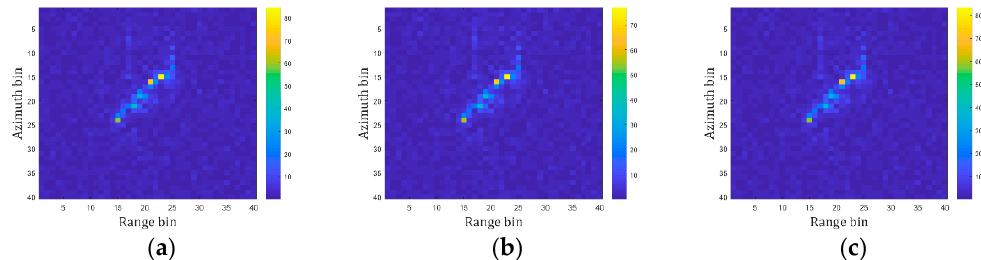
Figure 14. Descalloping effect on the ship: ( a ) ship in the SS image; ( b ) ship in the simulated ScanSAR image; ( c ) ship in the desclloping image.